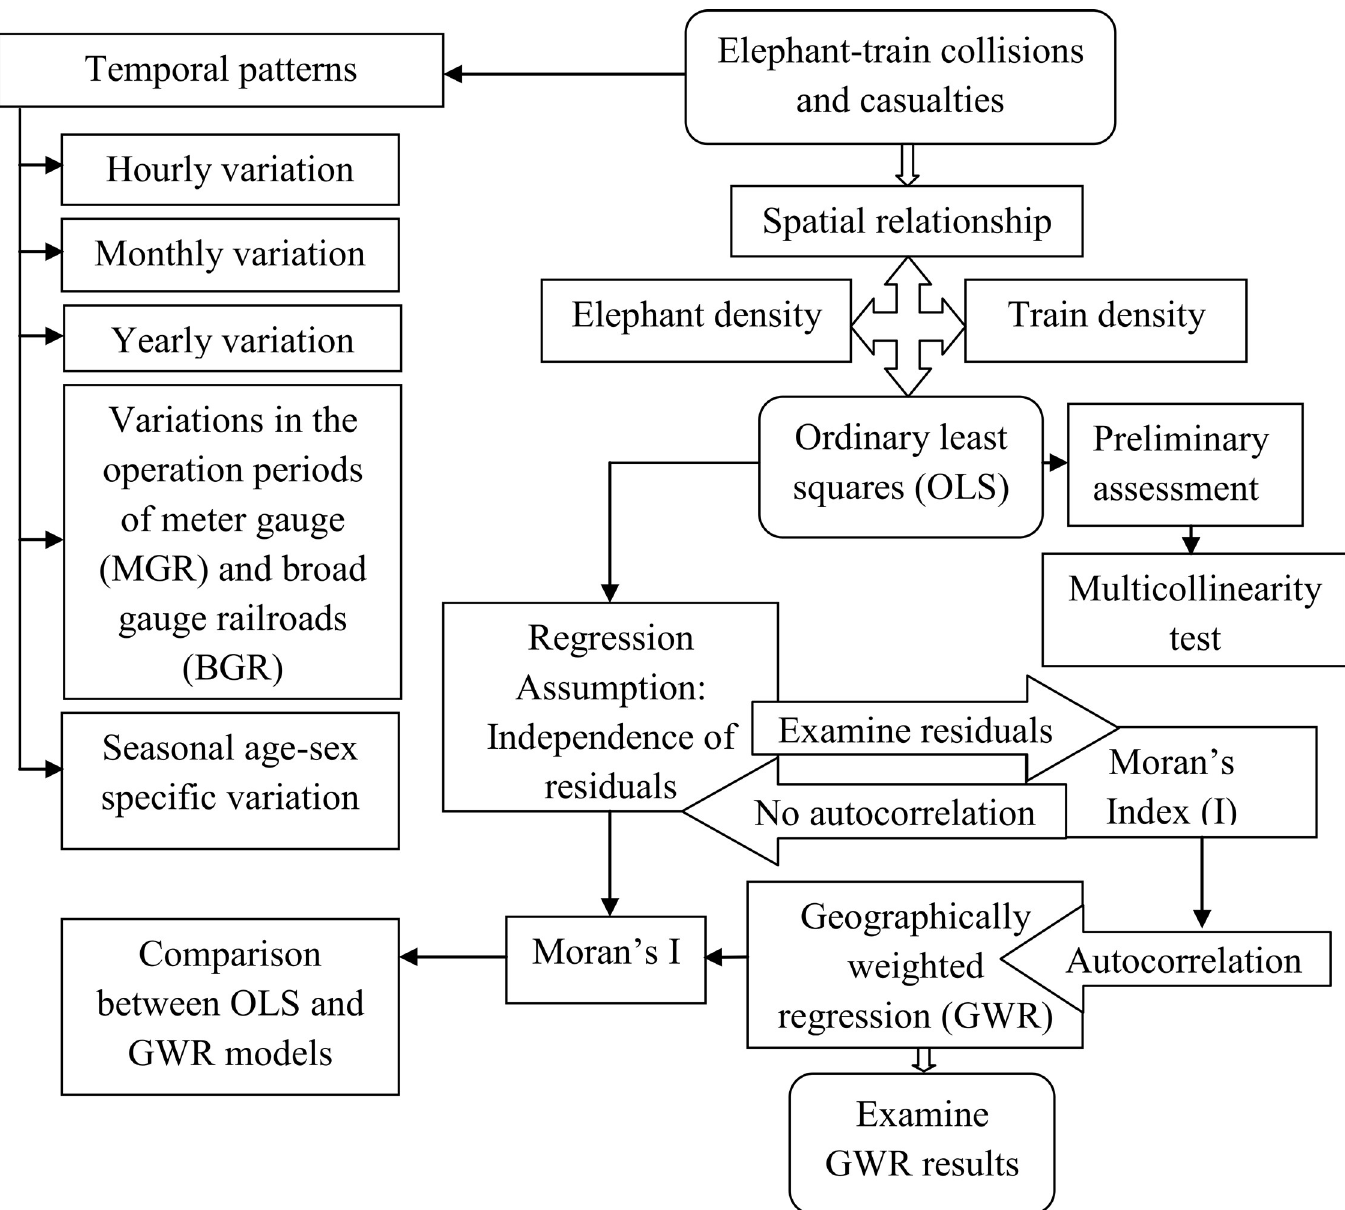
Fig 2. Flowchart showing the methodology adopted to determine spatially varying relationships between elephant-train collision and casualties vis-a-vis elephant and train densities in 10 km 2 grid cells of 11 railroad segments using ordinary least squares and geographically weighted regression. https://doi.org/10.1371/journal.pone.0271416.g002 2.4.2 Regression models. Both OLS and GWR analyses were carried out in ArcGIS 10.1.